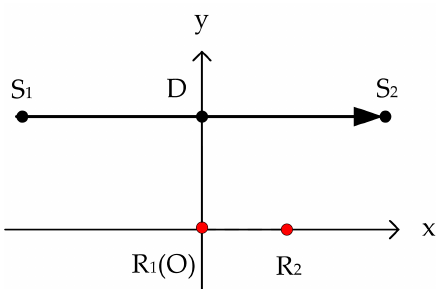
Figure 4. Side view of the geometric conditions for hydrophone deployment and ship track. The target ship sailed through the distance from S 1 to S 2 on the water surface. The hydrophones R 1 and R 2 were suspended at the depth of DO (vertical distance between the hydrophones and water surface) and floating parallel to the water surface for acoustic signal acquisition.